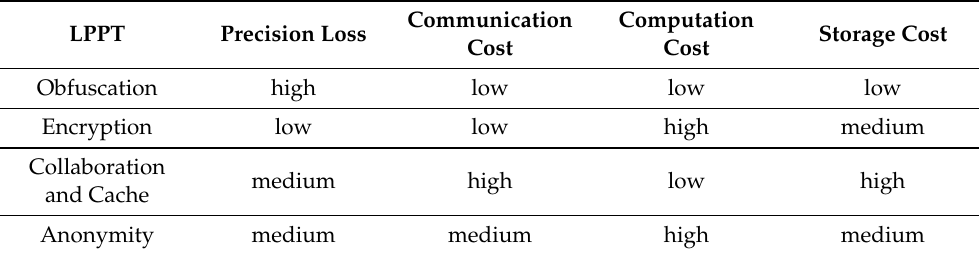
Figure 2. The relationship among location privacy, location privacy protection techniques, the obfuscation, and dummy location. Table 2. The cost of four privacy protection